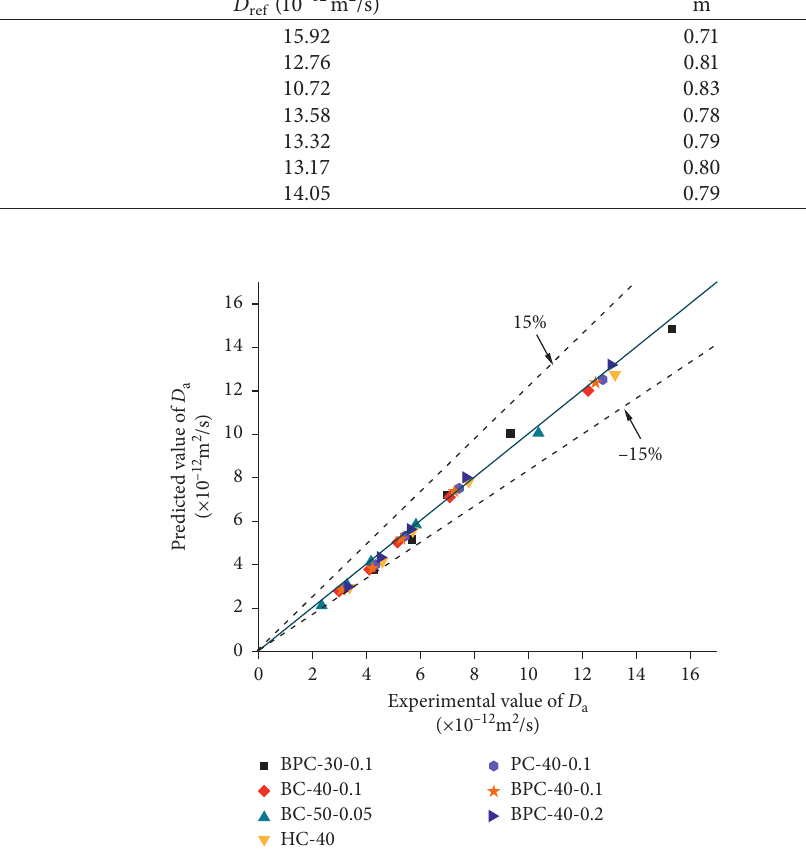
Figure 12: Comparison between predicted and experimental values of (D)